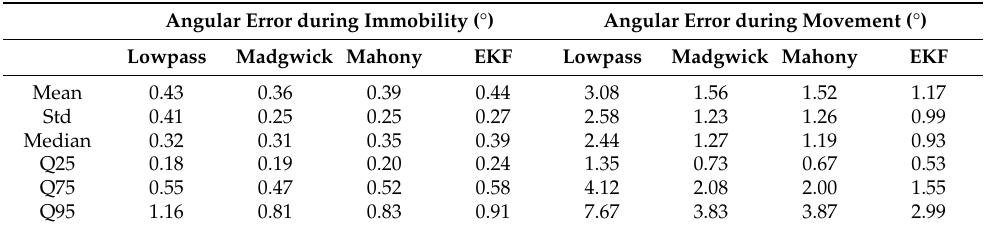
Table 1. Angular errors in IMU-based head tilt estimation for different types of filters. The following optimal parameters were used: cutoff frequency of 2Hz for the low-pass filter; β = 0.1 (filter gain) for the Madgwick filter; k P = 0.3 (proportional filter gain) and k I = 1.8 (integral filter gain) for the Mahony filter; v g = 1.0deg 2 s − 2 and v a = 0.002 g 2 (noise variance for gyroscopes and accelerometers, respectively) for the extended Kalman filter. Std: standard deviation; Q25, Q75 and Q95: 25th, 75th and 95th percentiles, respectively. Angular Error during Immobility ( ° ) Angular Error during Movement ( ° )